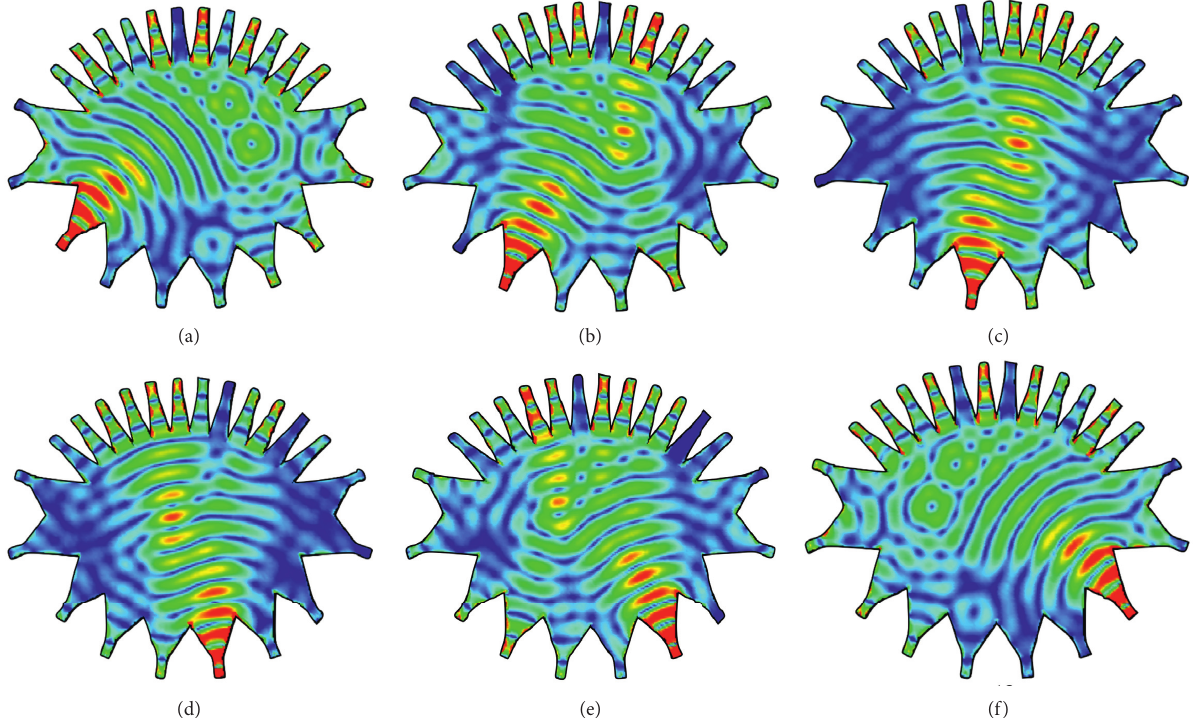
Figure 19: K-band Rotman lens: current distribution in (a) port 3, (b) ports 2, (c) port 1, (d) port − 1, (e) port − 2, and (f) port − 3 at f � 24 . 0 c